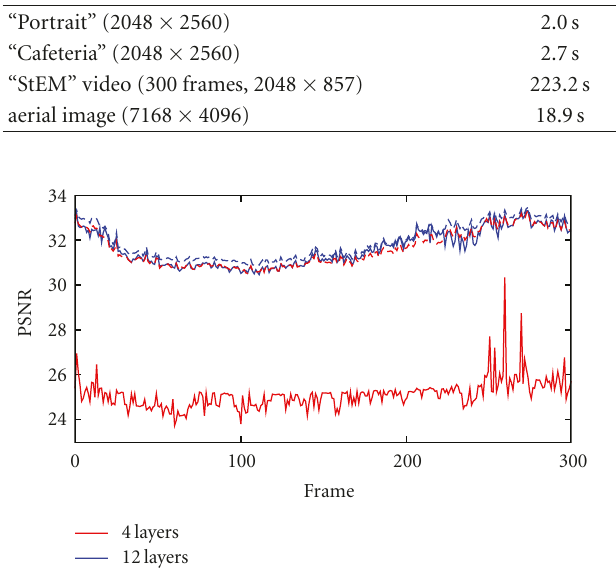
Figure 6: Visual comparison between a WOI transmitted using the common approach of layer truncation (a) and BWLT (b). The WOI size is 830 × 660, and belongs to an aerial image compressed to a single quality layer codestream (transmitted 105 KB). Table 1: Evaluation of the computational costs of four methods of layer truncation. Results are reported in seconds. Full reencoding